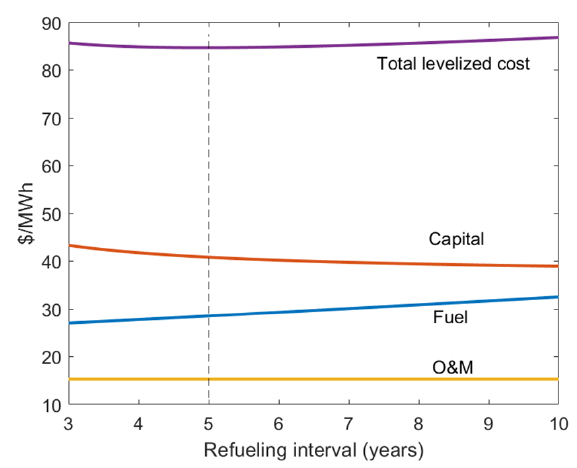
Figure 11. NB levelized electricity costs vs. refueling interval.